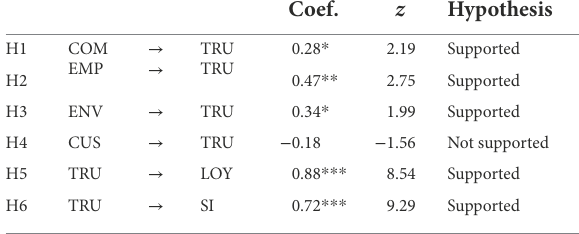
TABLE 4 The SEM results of each relationship in the proposed model.